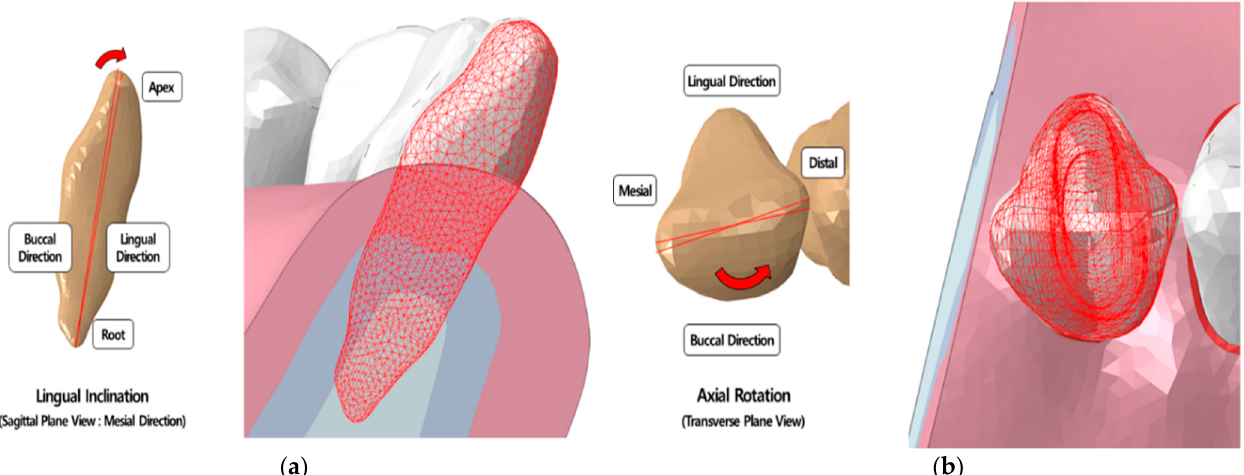
Figure 4. Tooth-alveolar bone model of mild crowding dentition ( a ) Buccal 1.5° inclined rotation of the central incisor ( left ) and deformation of the central incisor compared to normal tooth-alveolar bond model (red); ( b ) Five-degree external axial rotation of the central incisor ( left ) and deformation of the central incisor compared to normal tooth-alveolar bone model (red); the components are equal to that of normal tooth-alveolar bone model except for the central incisor.